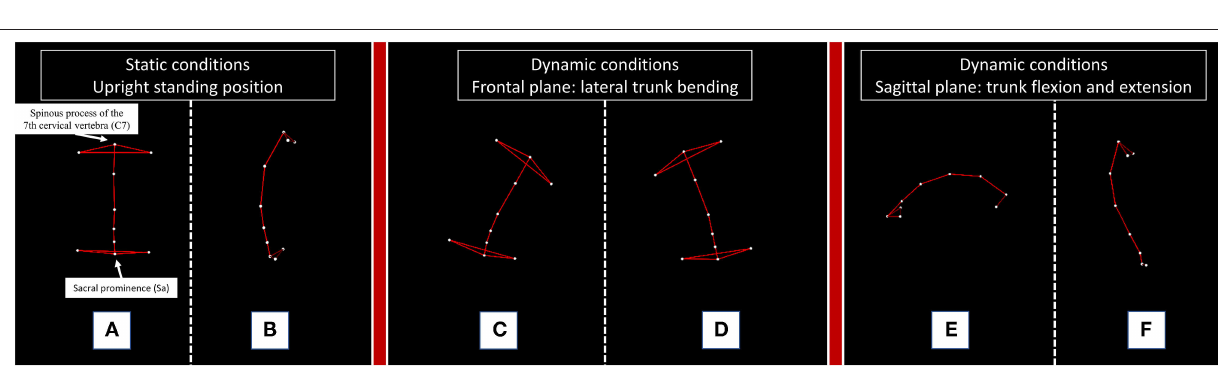
FIGURE 1 | Flowchart of study procedures. t-DCS: patients randomized to transcranial direct current stimulation ( n = 13). sham: patients randomized to sham stimulation ( n = 15).